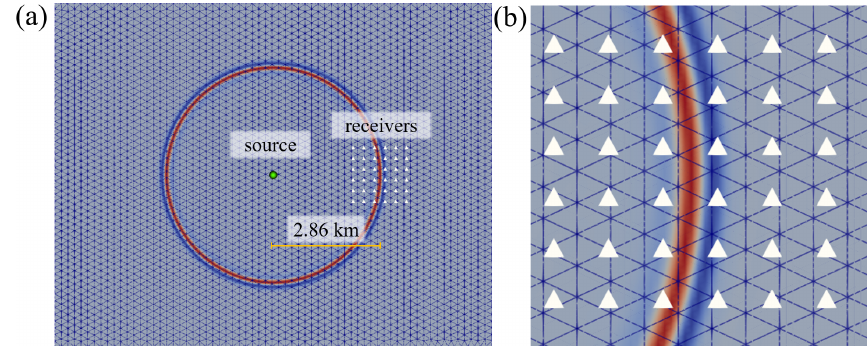
Figure 7. The experimental configuration to calculate the grid-point-per-wavelength G values. In panel (a) the source is shown as a green circle and the receivers are denoted as white triangles with a close-up of the bin of receivers shown in panel (b) . In both panels, the normalized wave field is colored at t = 2 . 25s.